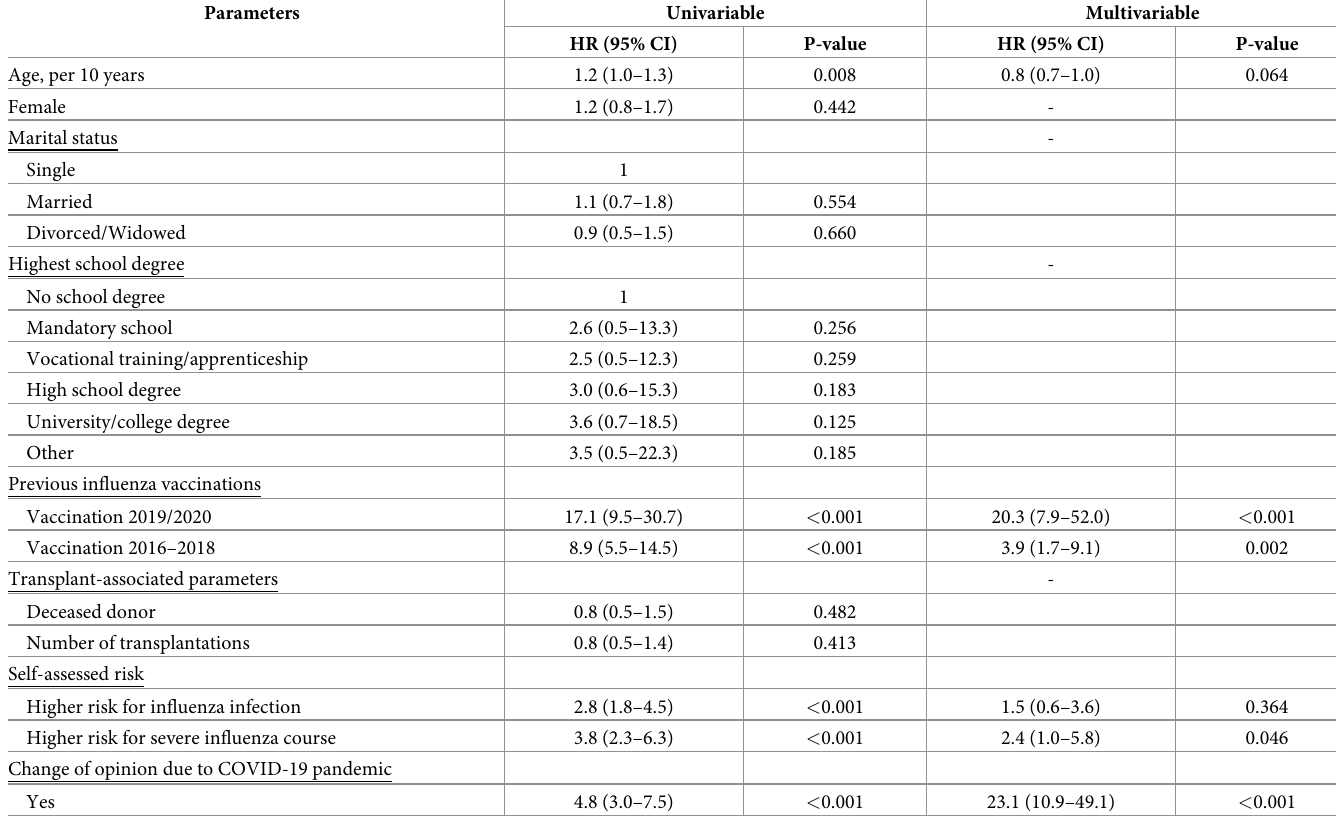
Table 2. Uni- and multivariable regression analysis evaluating factors associated with vaccination